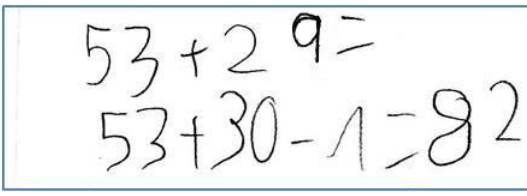
Figure 34. Work out 53 + 29.